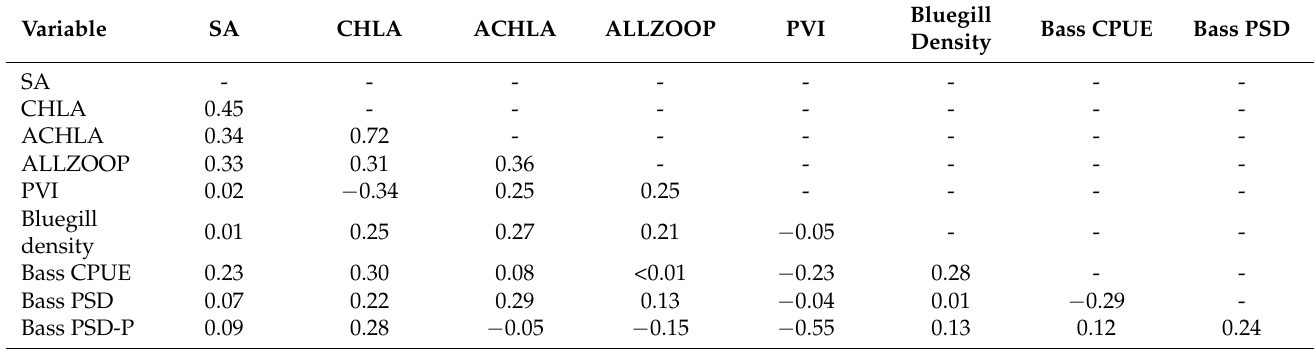
Table 2. Pairwise correlations (Pearson product-moment correlation coefficients) among abiotic and biotic factors used to model Bluegill population demographics. Abbreviations include surface area (SA), chlorophyll- a concentration (CHLA), adjusted chlorophyll- a concentration (ACHLA), zooplankton density (ALLZOOP), percent of total lake volume inhabited by macrophytes (PVI), Bass (Florida Bass), electrofishing catch per unit effort (CPUE), proportional size distribution (PSD),